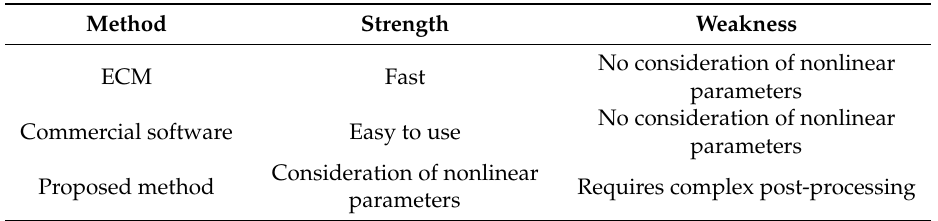
Table 1. Comparison between the equivalent circuit method (ECM), commercial software, and the proposed method.